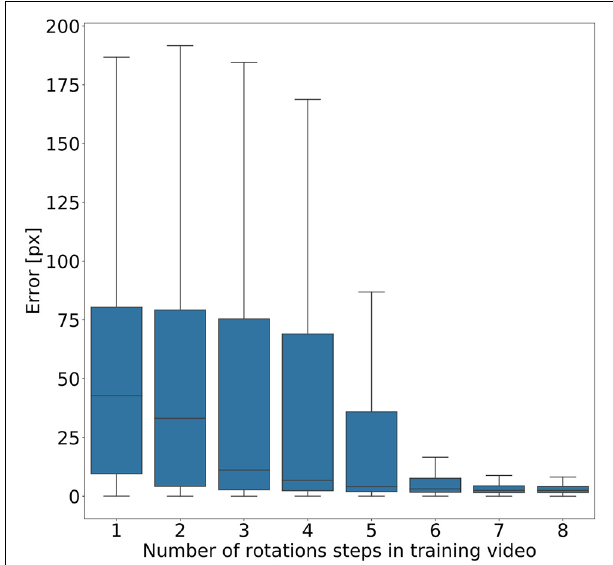
FIGURE 6 | Rotation by at least 180 ◦ greatly improves performance. Average pixel error for eight models with varying degree of rotation. Rotations were applied in steps of 45 ◦ , with model number indicating the cumulative number of rotation steps. Model 5 is the first model that was trained on postures with a rotation range larger than 180 ◦ . Models that were trained on videos with six or more rotation steps have the least error. Note that, for the sake of clarity, outliers are not shown. As yet, all data points were included in any and all statistical computations. The scale factor converting pixels to mm was in the range of 0.18–0.55 mm/pixel, depending on the scaling factor of the random